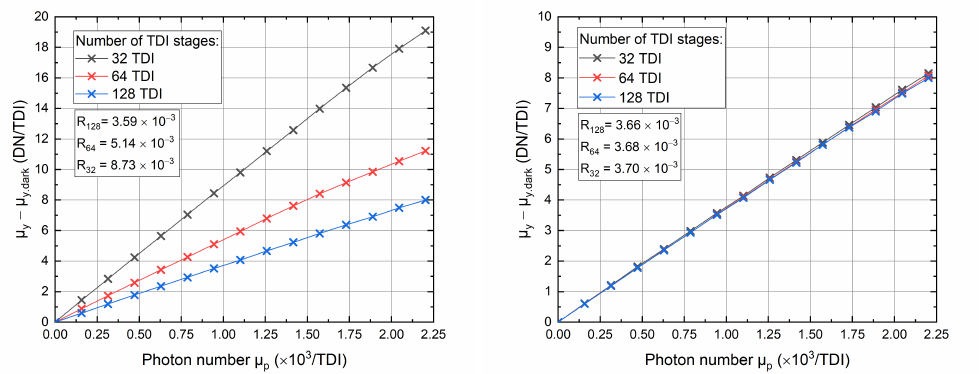
Figure 5. Responsivity curves measured without ( on the left ) and with ( on the right ) integration of the anti-blooming clocking for different numbers of TDI